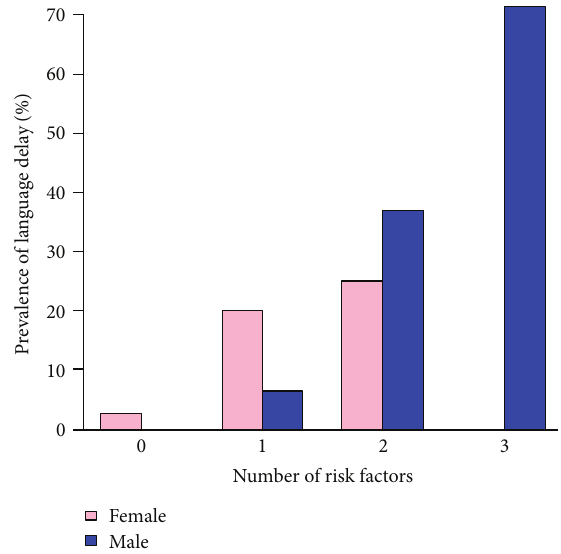
Figure 1: Prevalence of language delay at 30 months in relation to number of risk factors, by